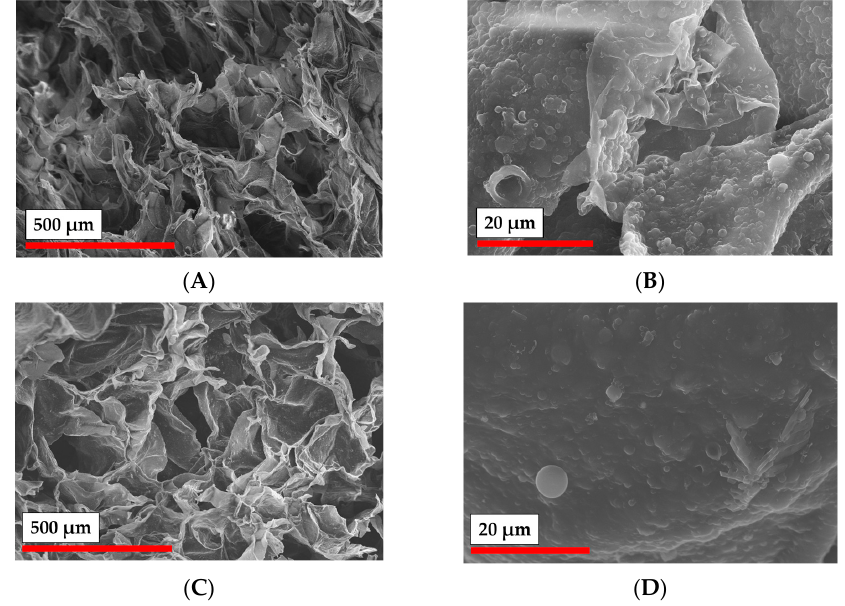
Figure 10. SEM images of matrices obtained by cryogelation of PLA-MA NPs with NCC-MA with different cross-linkers at different magnification: ( A ) Gel-MA (×100); ( B ) Gel-MA (×2000); ( C ) PEGDA (×100); ( D ) PEGDA (×2000).